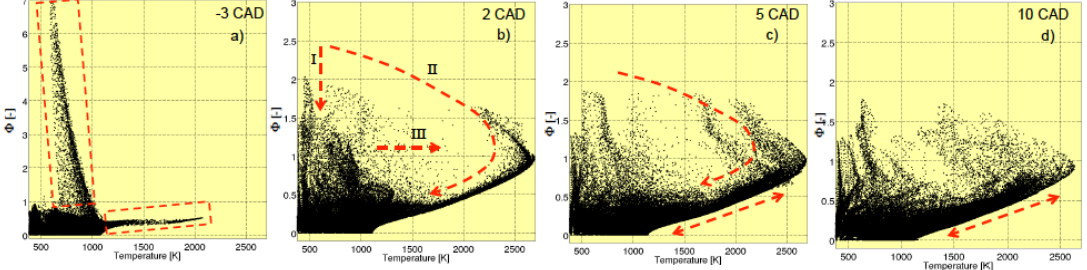
Figure 7. Fuel and air charge stratification from LES for the baseline case 1.